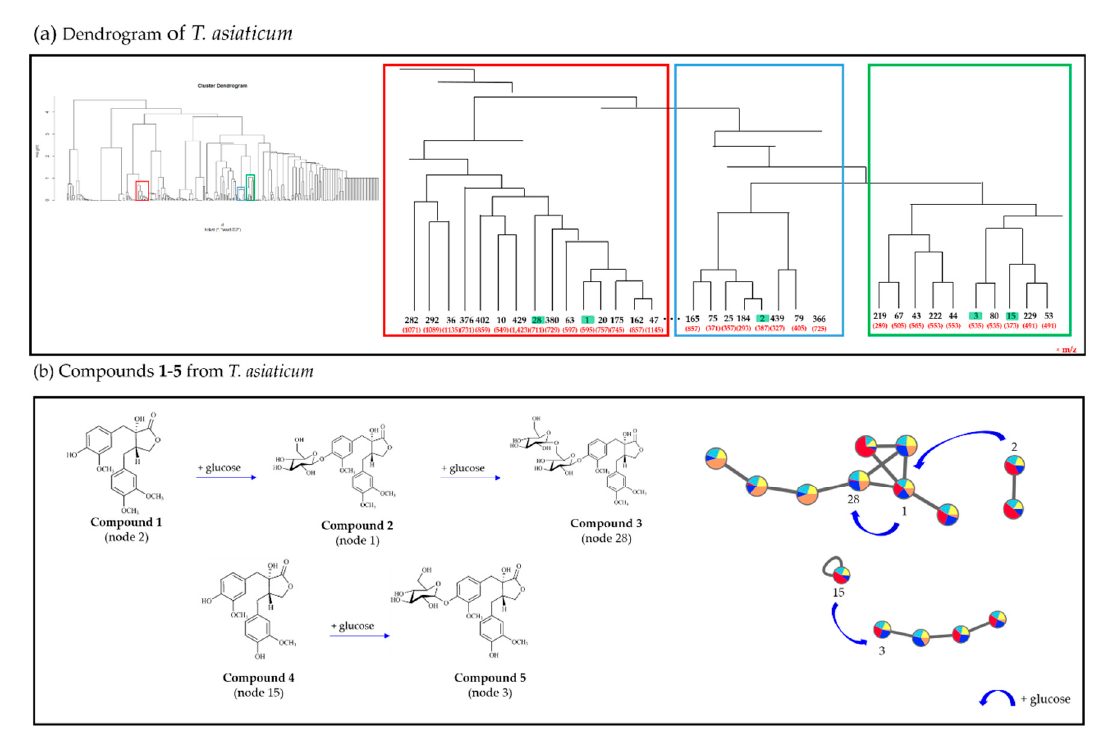
Figure 4. Compounds 1–5 identified based on molecular networking and HCA results.